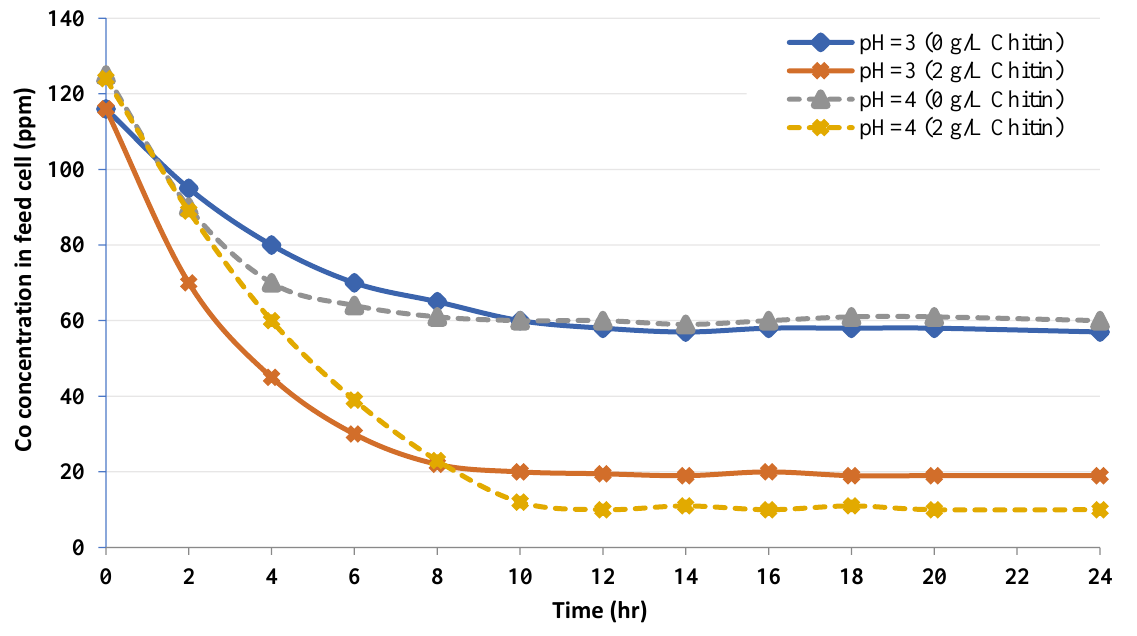
Figure 1. Kinetics of Co uptake by chitin at pH = 3 and pH = 4.